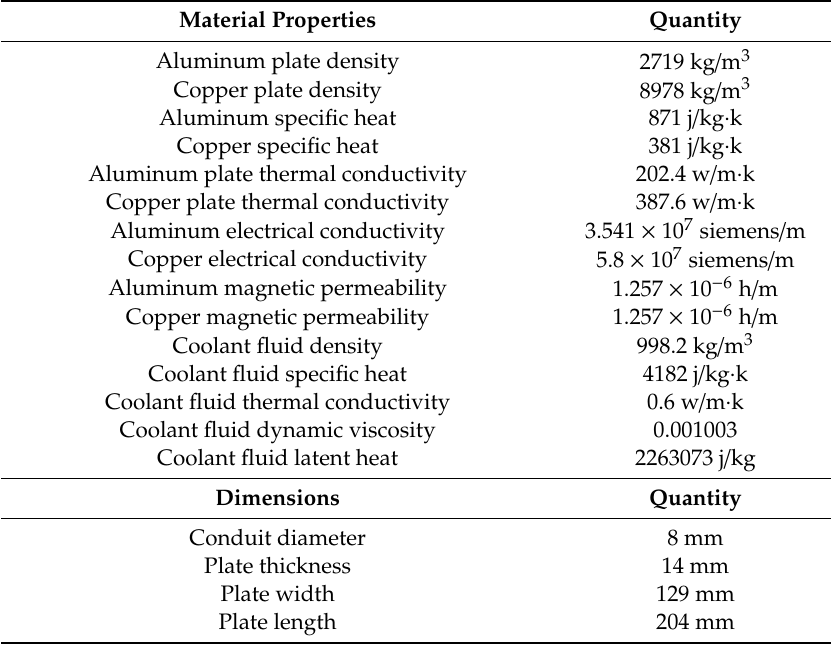
Table 1. Analysis parameters of the cooling